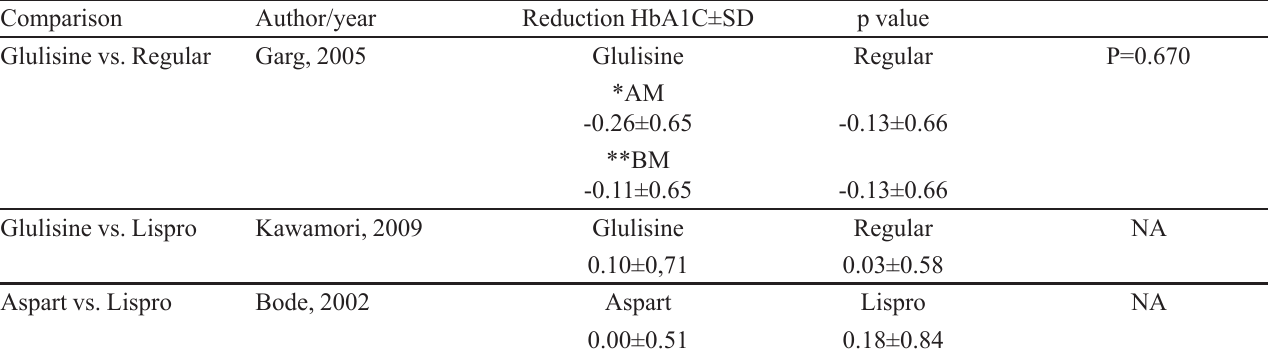
TABLE I - HbA1C reductions, SD and p values for the following comparisons: glulisine vs. regular insulin, glulisine vs. lispro and aspart vs. lispro